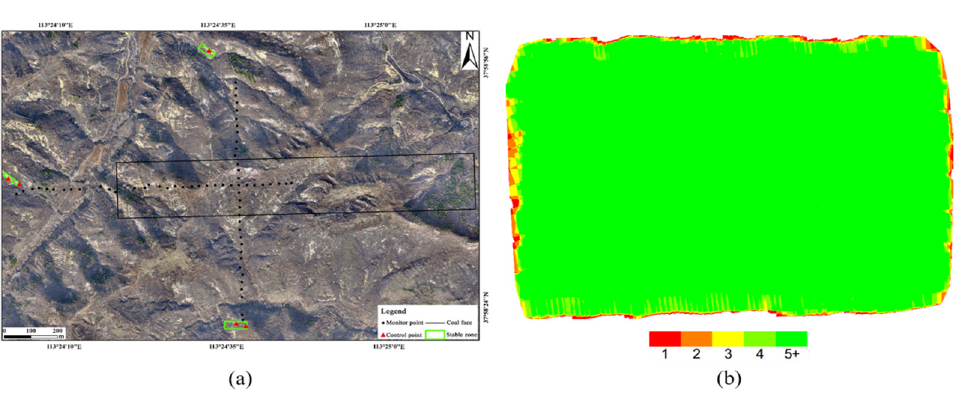
Figure 2. The flow chart for subsidence monitoring via UAV.